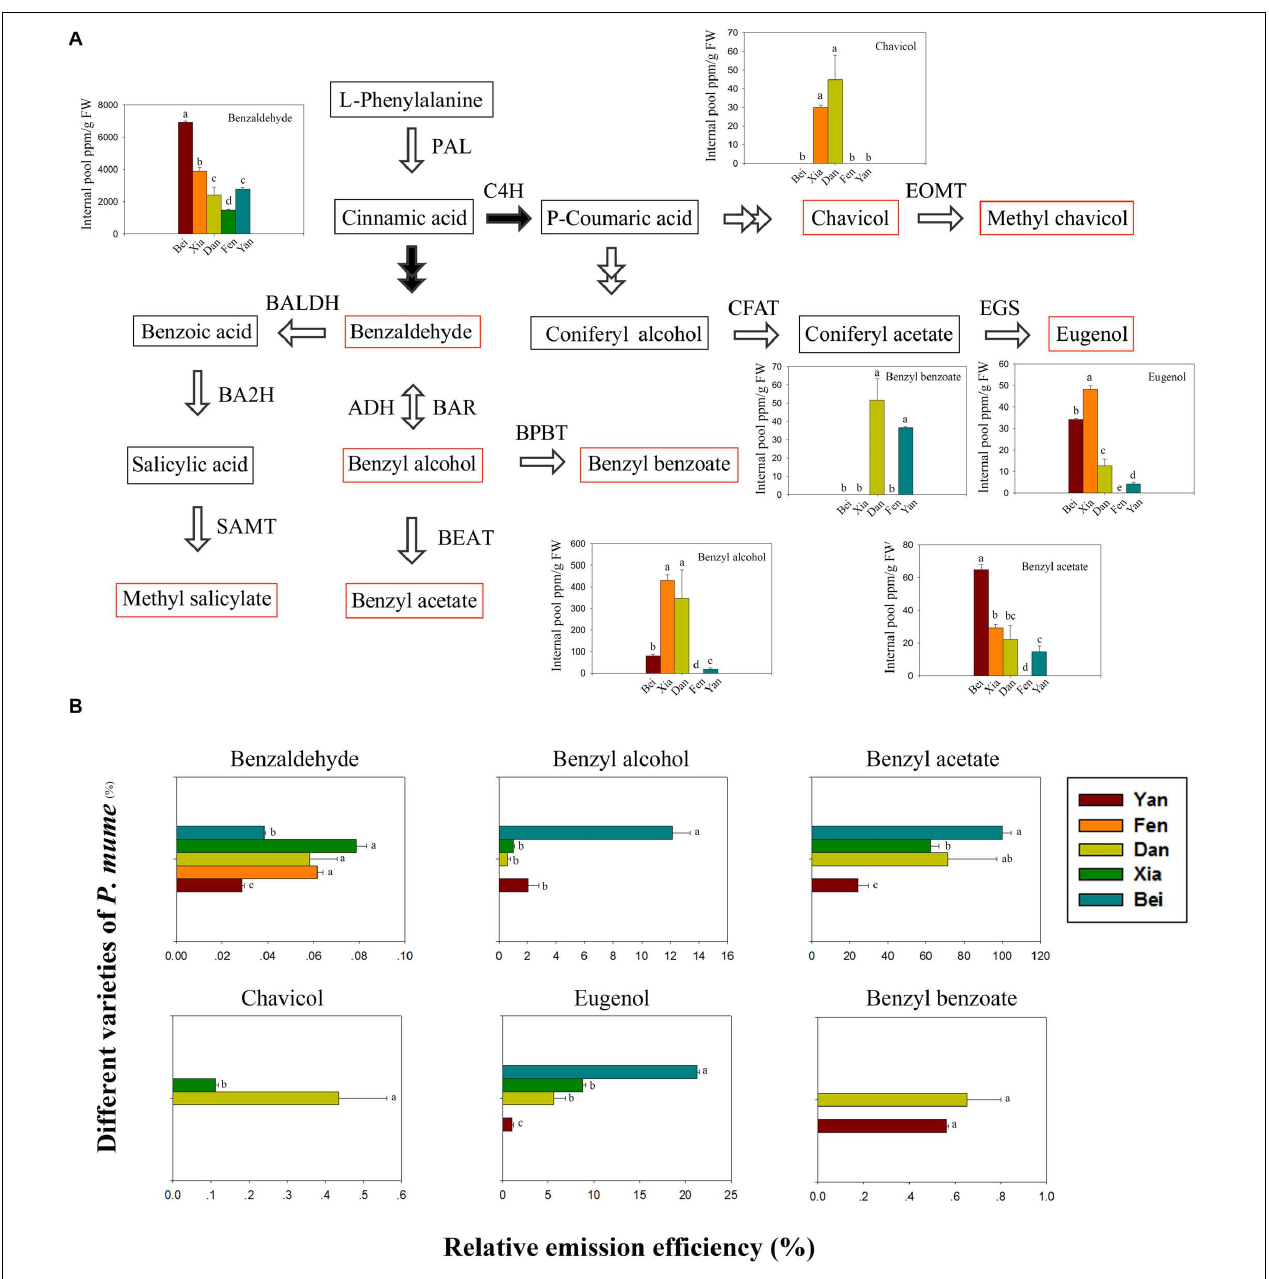
FIGURE 2 | Floral scent biosynthetic pathway and intracellular pools and emission efficiencies of fragrance components. (A) The floral scent biosynthetic pathway in P. mume is shown. The black arrows indicate the starting steps of the trans -cinnamic acid and para -coumaric acid pathways. The red rectangles indicate the metabolites that were detected in the headspace. The colored graphs show the intracellular pools of floral scent metabolites. The data are presented as the mean values of three biological replicates ± SDs. Different letters indicate significant differences at the P = 0.05 level. (B) The relative emission efficiencies of different components in the different varieties. The data are presented as the mean values of three biological replicates ±